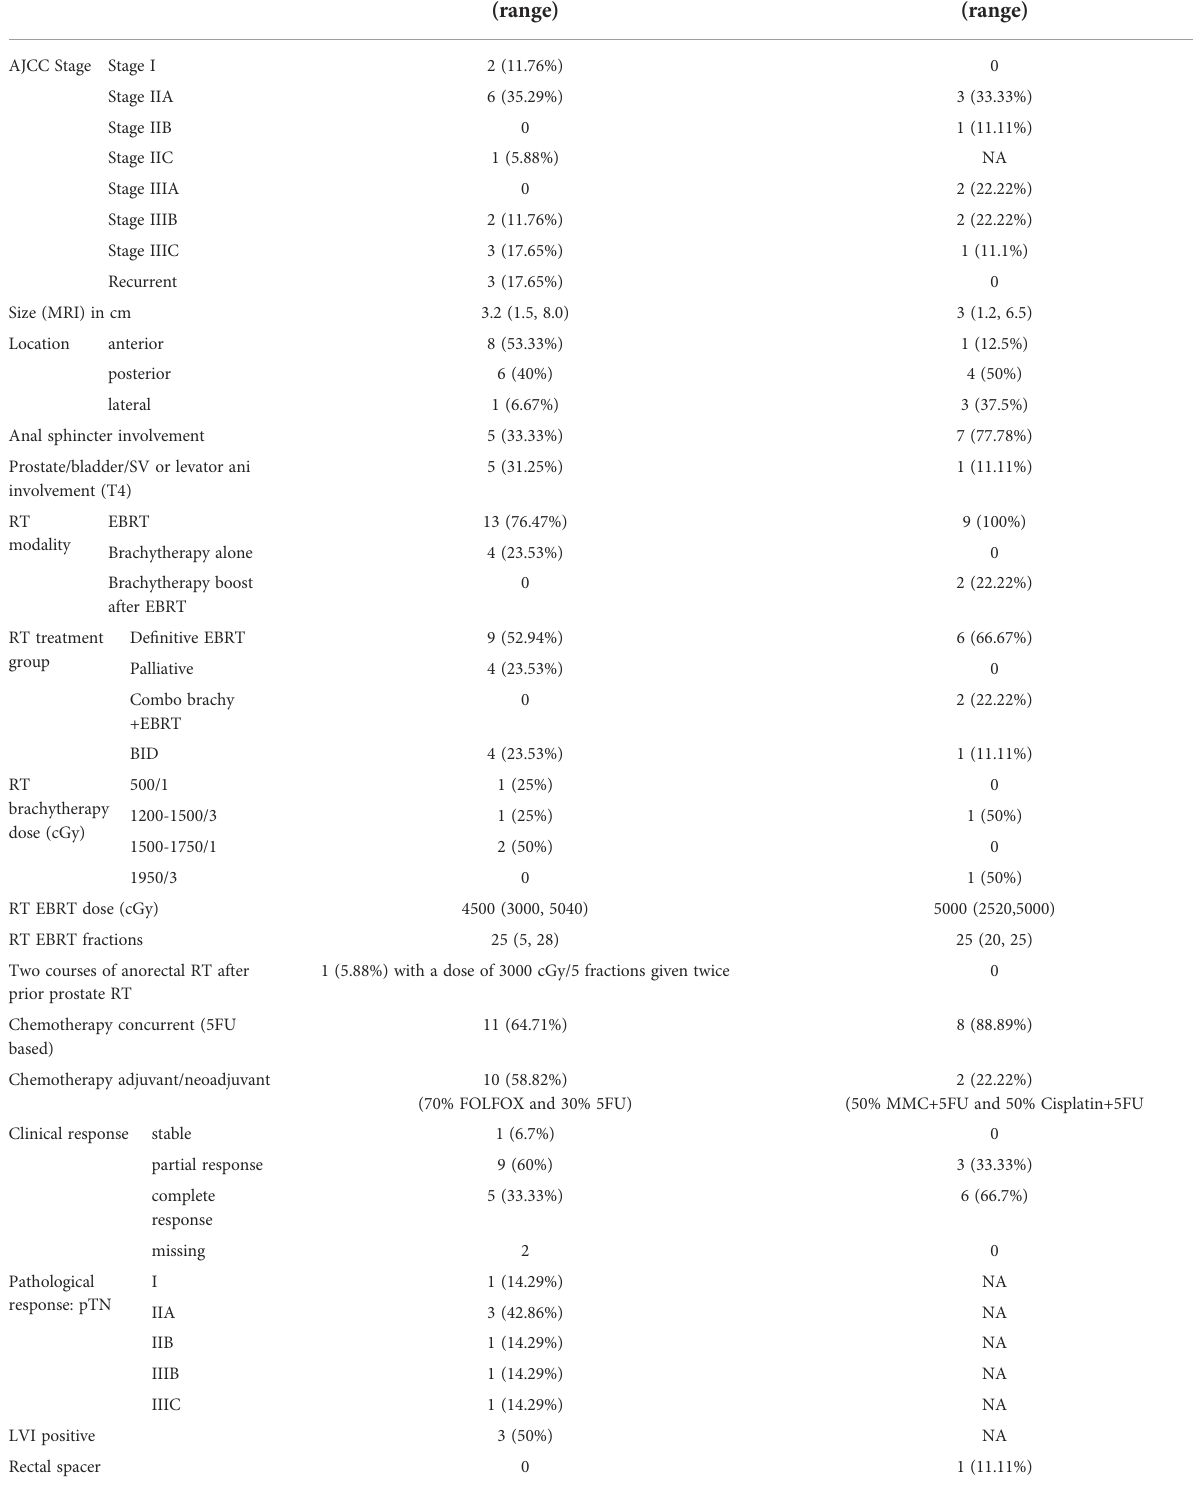
TABLE 2 Tumor characteristics, treatment characteristics, and response for patients treated with radiation therapy for de novo rectal and anal cancers after prior prostate RT.